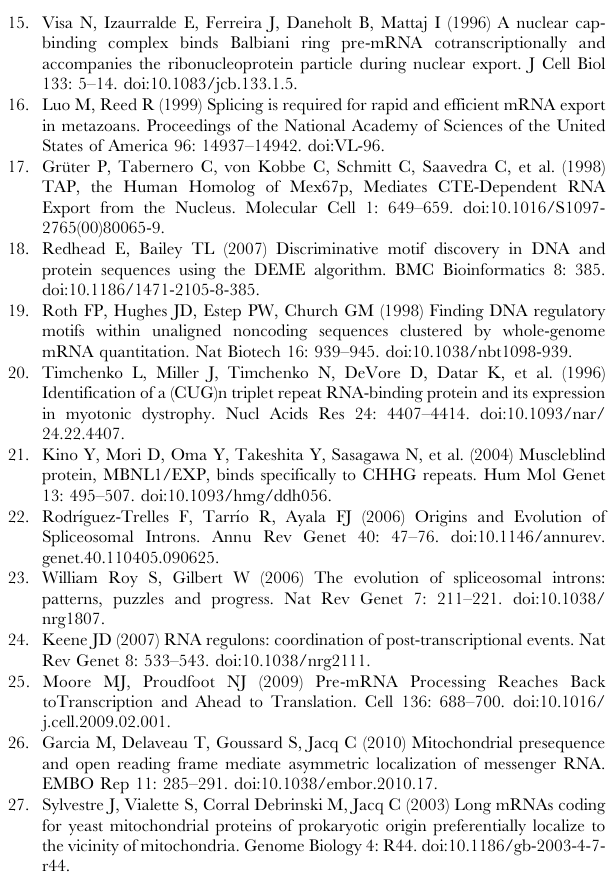
[(A) 54.1% versus 28.5%; (B) 57.7% versus 36.8%; (C) 59.1% versus 38.5%; and (D) 61.5% versus 41.2%] and in terms of fraction of sequences with multiple motif occurrences [(A) 32.4% versus 11.8%; (B) 28.0% versus 13.2%; (C) 31.0% versus 12.8%; and (D) 34.5% versus 17.9%]. Figure S8 Discriminative motifs discovered by AlignACE are also predictive of 5UI absence among MSCR-containing genes. ROC plots are as described in Figure 6G for the four AlignACE motifs that were most enriched among 5UI 2 genes in descending order of enrichment (panel A-D). Figure S9 Three of the four discriminative motifs discovered by AlignACE reveal a strong bias for a particular frame of translation. The four AlignACE motifs that were most enriched among 5UI 2 genes, in descending order of enrichment (panel A-D). The positions of all motif occurrences were classified into one of three possible frames of translation. The fraction of motif occurrences in each frame of translation was plotted for both 5UI 2 and 5UI + genes. Table S1 5UIs are depleted from ER-Targeted and Mitochon- drial Genes. The GO analysis was done using the FuncAssociate [34,35]. The functional categories are sorted in descending order based on their log-odds score (LOD). All categories with a LOD score less than -0.1 and p-value , 0.05 are reported. Fisher’s Exact Test was used to calculate the statistical significance and correction